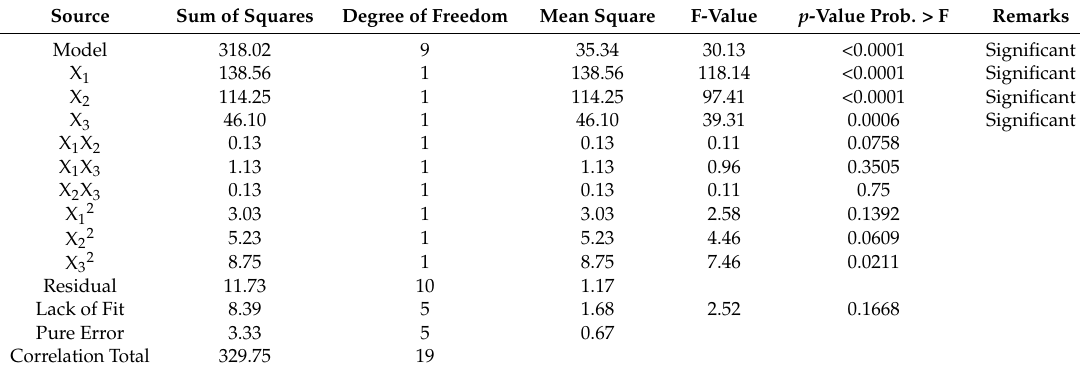
Table 4. ANOVA table for Zn 2+ removal efficiency on the composite